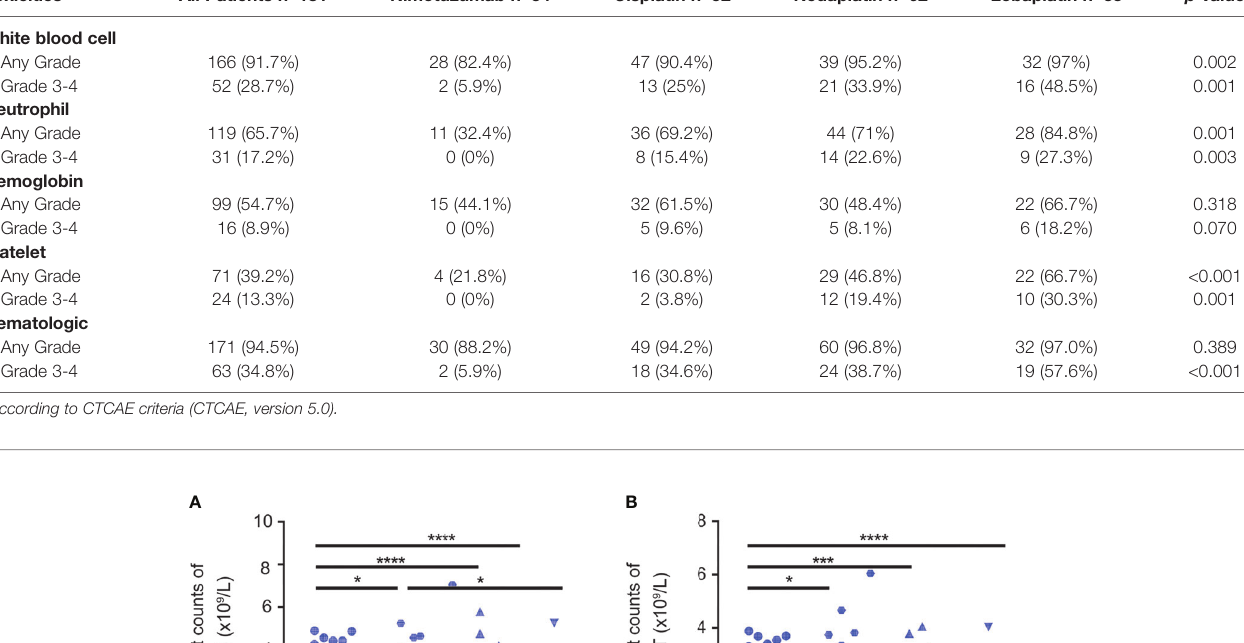
TABLE 2 | Concurrent chemoradiotherapy-induced myelosuppression in LAHNC patients. Toxicities* All Patients n=181